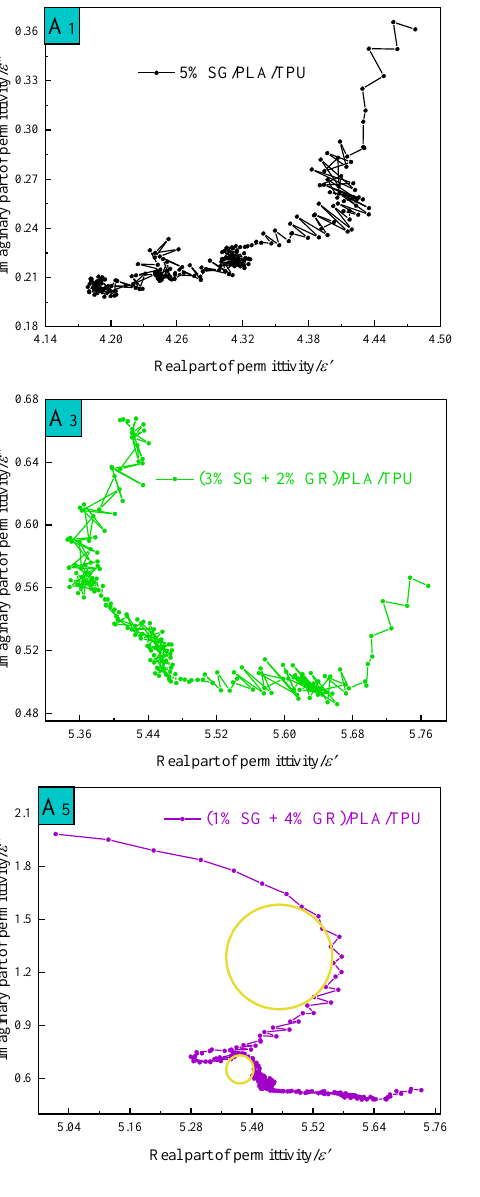
Figure 7. Cole – Cole curves of A 1 ~A 6 composites.